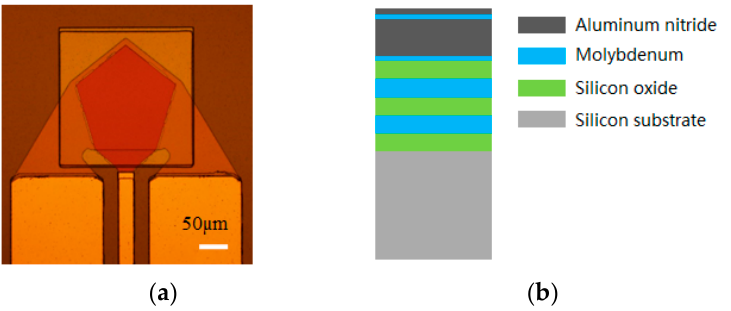
Figure 1. The schematic of SMR: ( a ) optical photo of SMR; and ( b ) cross-section of the pentagon region in ( a ).